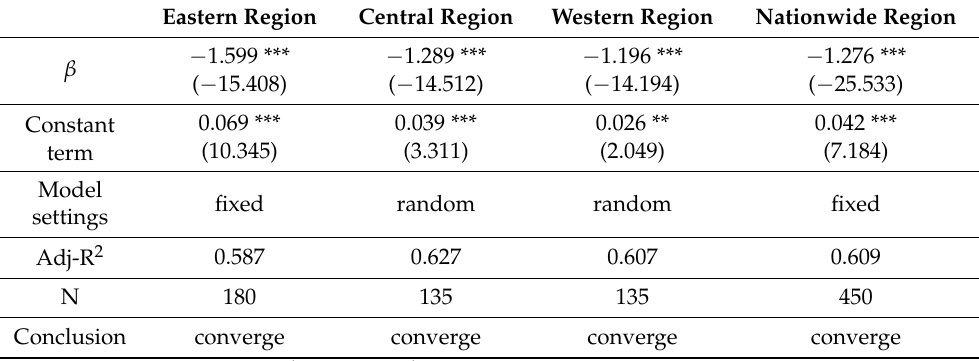
Table 7. Inter-provincial GTFP absolute β convergence tests for China.